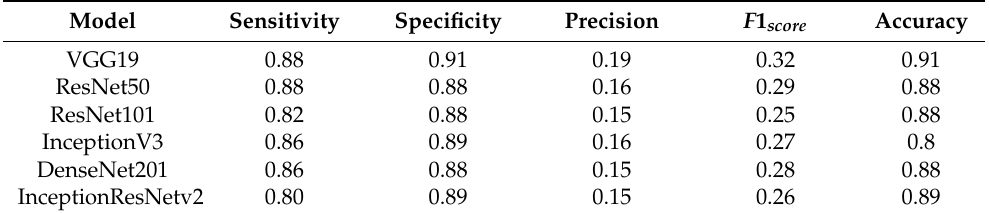
Table 4. The performance of the deep-learning models on mass classification when trained on the original training